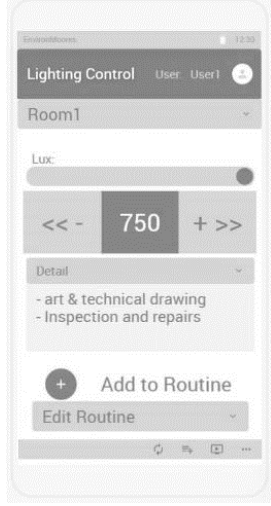
Figure 4. The proposed user interface for lighting control.